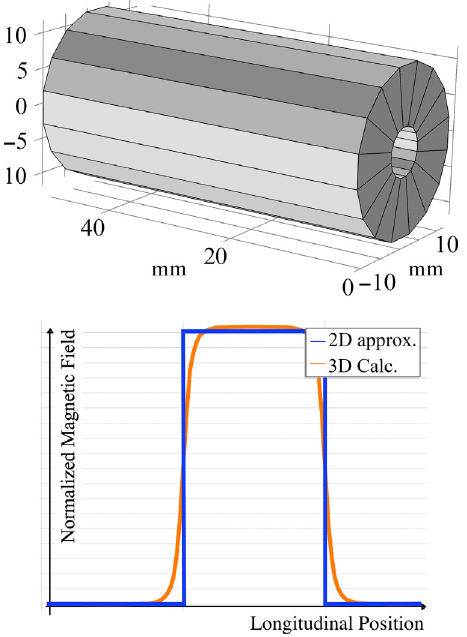
FIG. 11. Top: 3D model of the PMQ. Bottom: Comparison of the 3D simulation results to the 2D approximation of the magnetic field of the